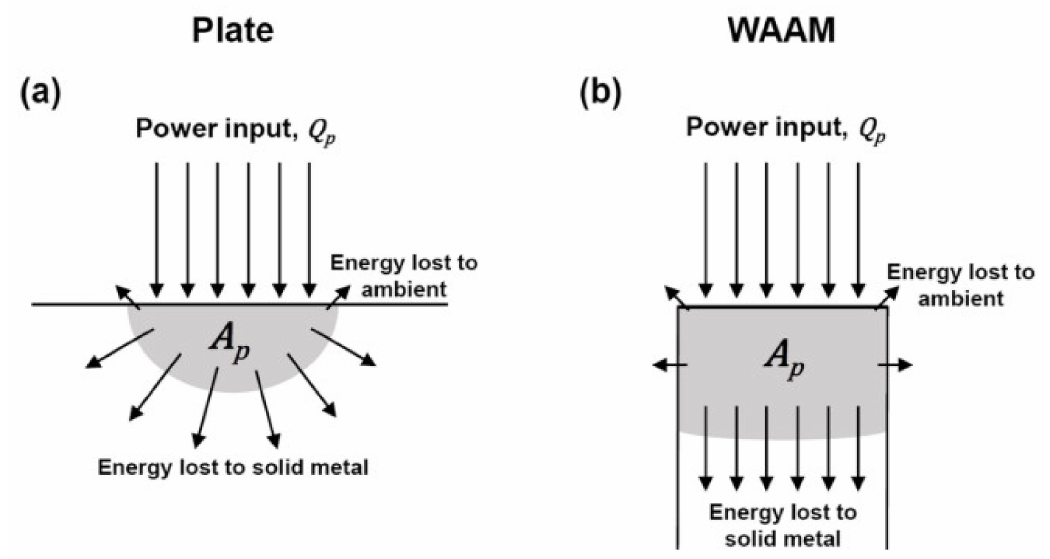
Figure 2. Heat transfer in joint welding and WAAM [8]. ( a ) thermal conductivity takes place in more dimensions; ( b ) thermal conductivity takes place in one